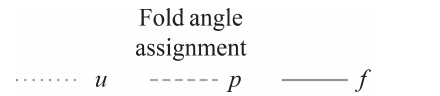
Figure 8. Legend giving the fold angles assignment of the example fold states.